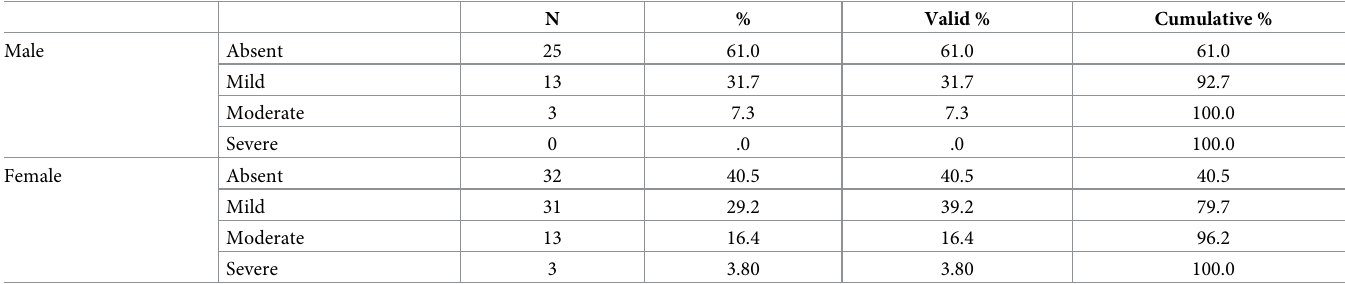
Table 4. Frequencies of the levels of somatization based on the PHQ-15 cut offs in the male and female samples. N